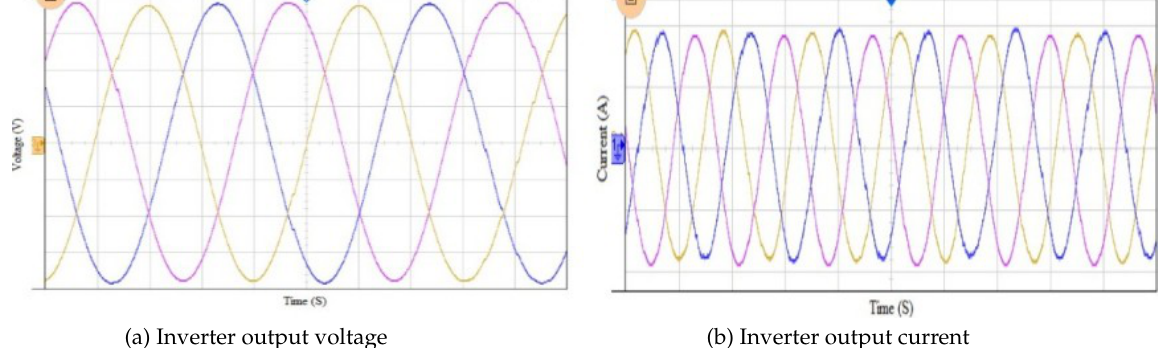
Fig. 13. Output voltage and current of voltage source